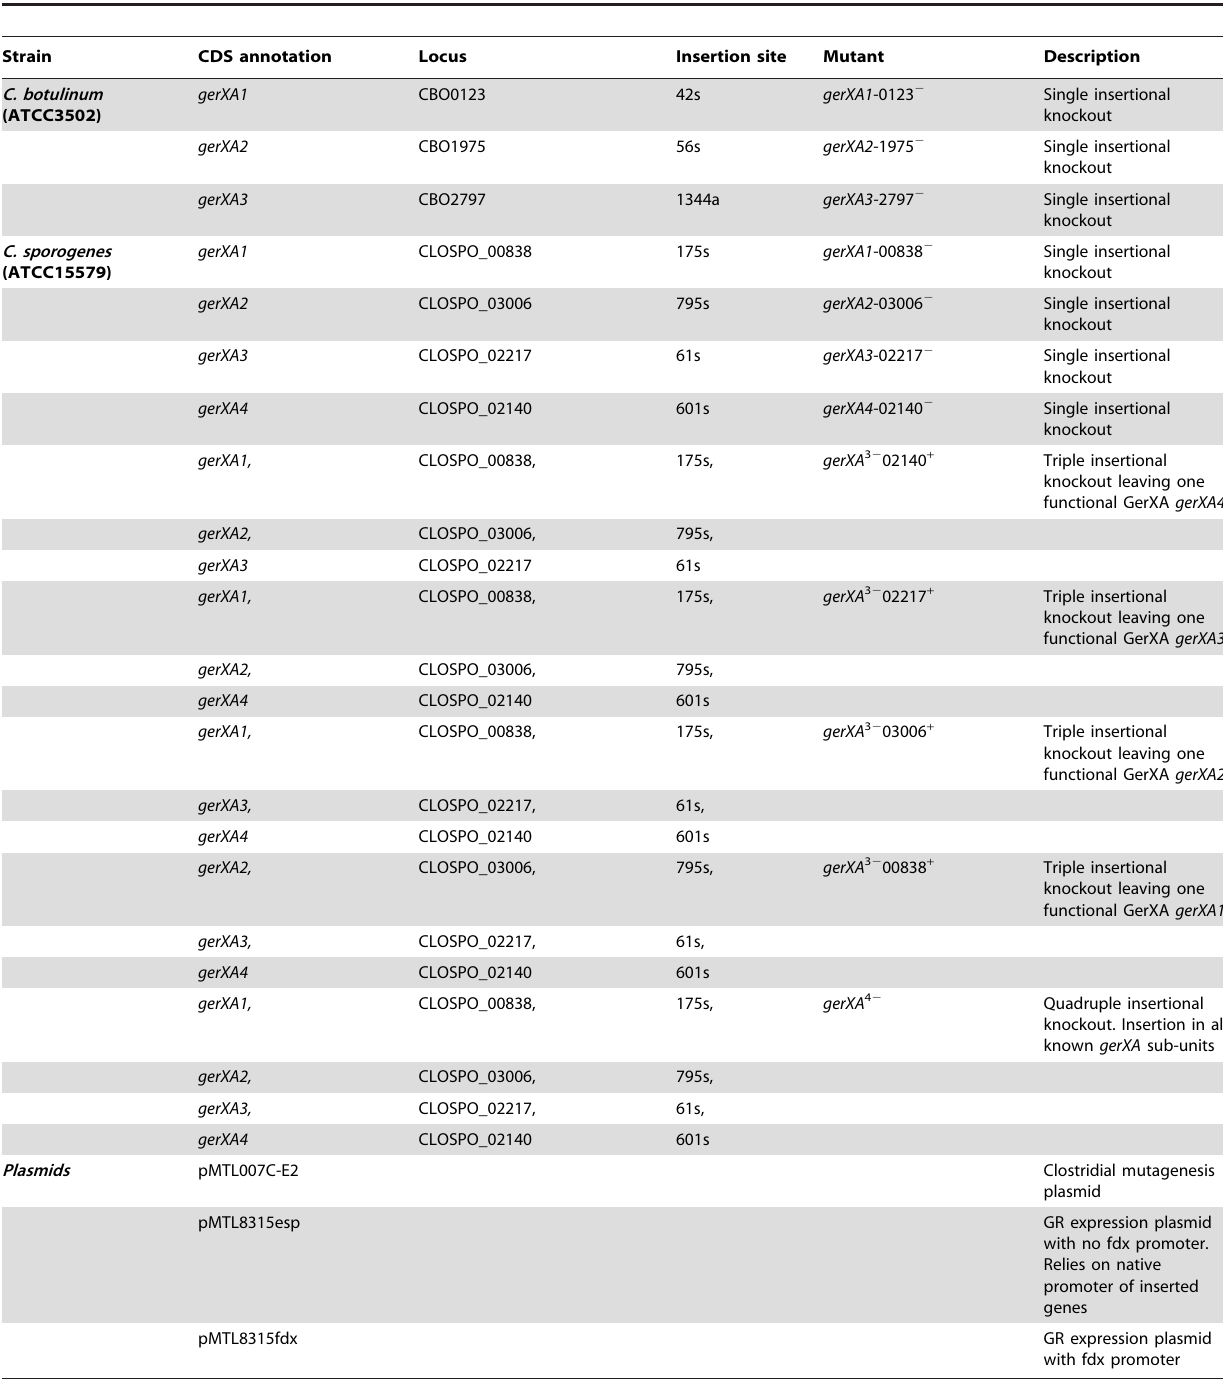
Table 2. Constructed mutants and plasmids utilised in this